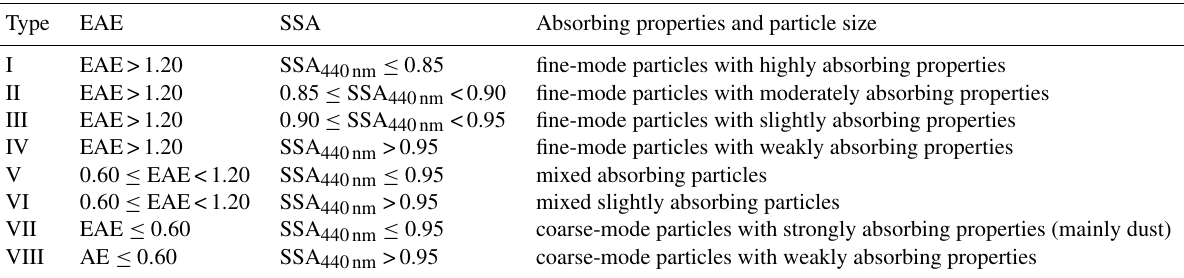
Table 1. Aerosol type classification based on the optical